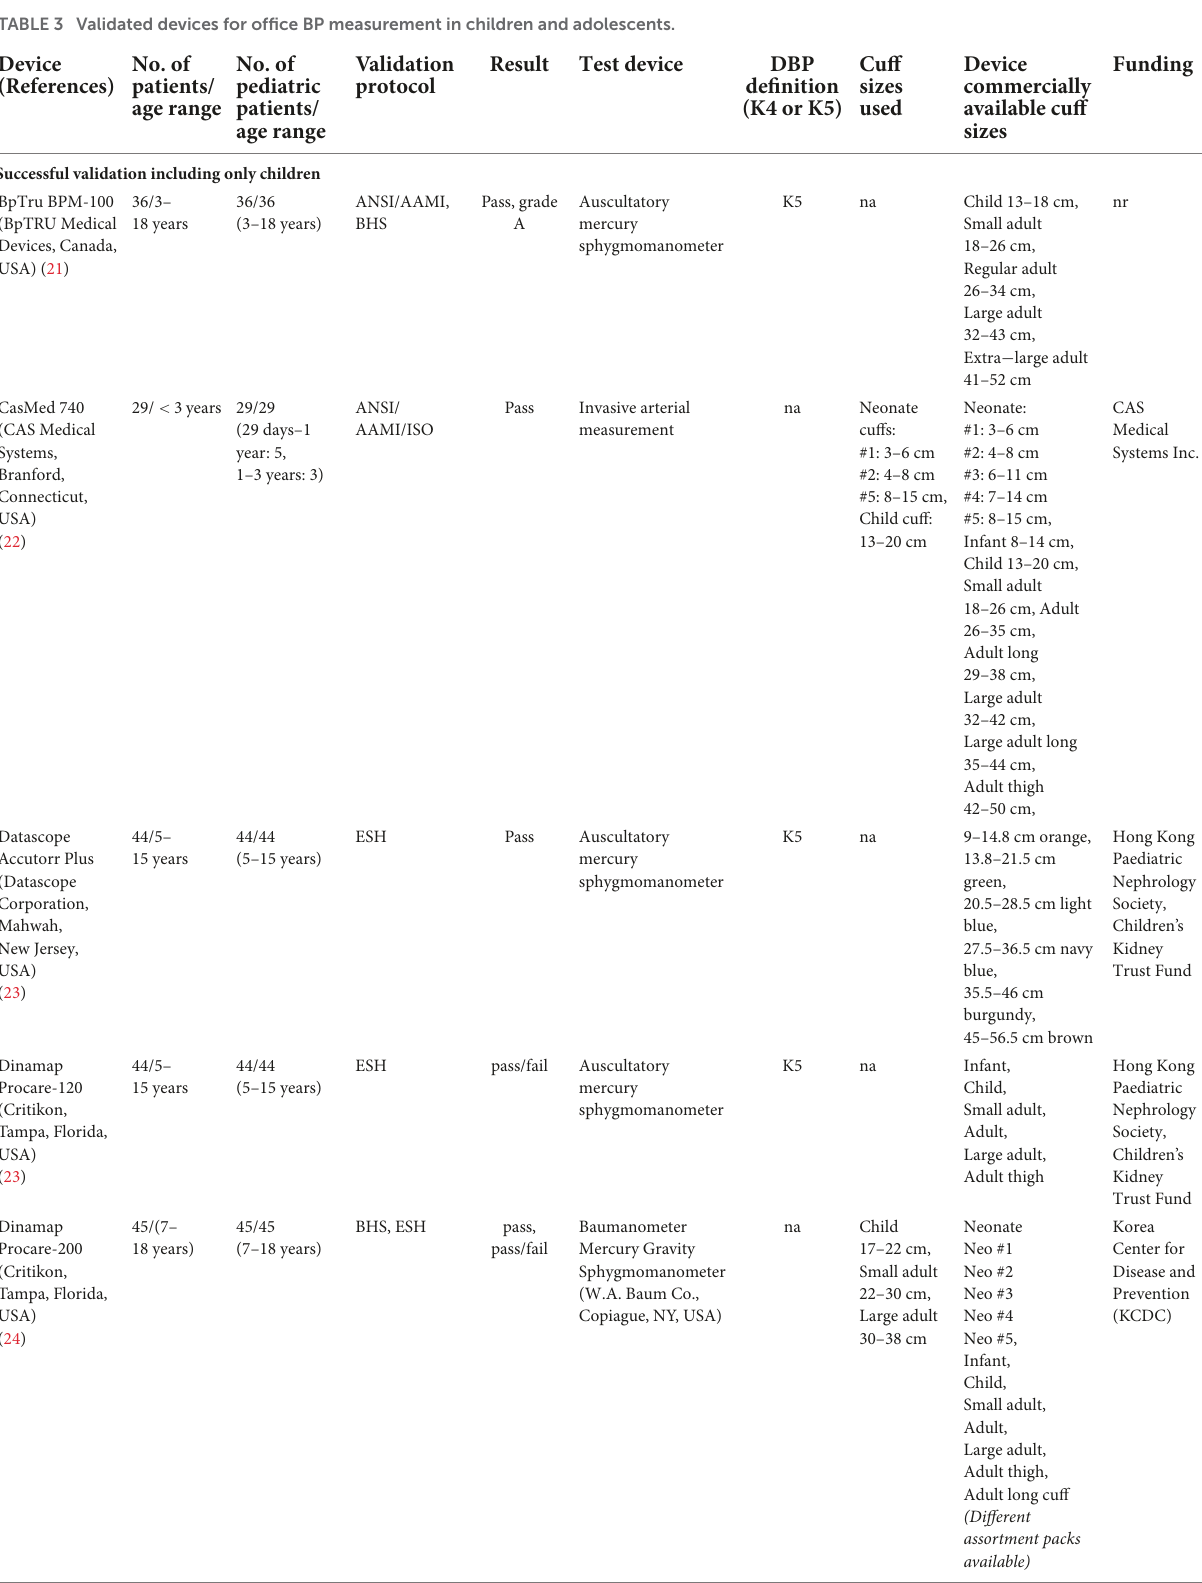
TABLE 3 Validated devices for office BP measurement in children and adolescents. Device No. of (References)